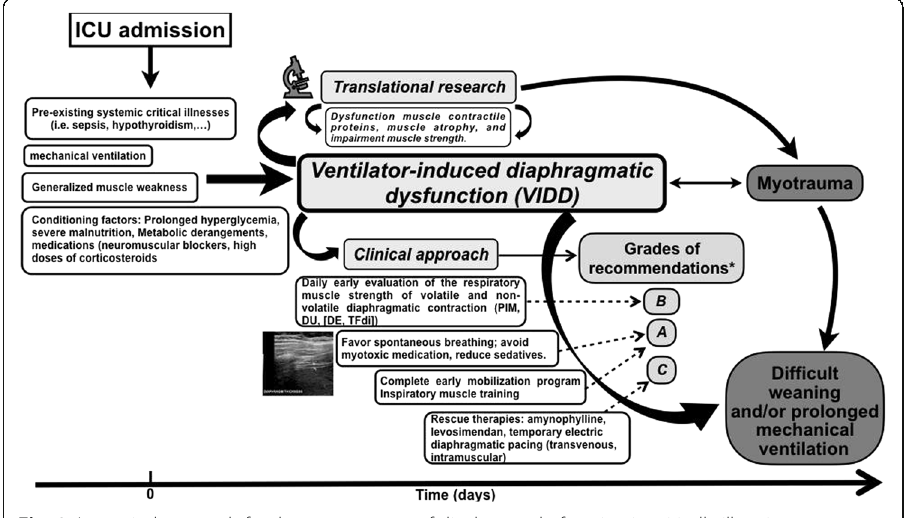
Fig. 3 A practical approach for the management of diaphragm dysfunction in critically ill patients. Abbreviations: DU, diaphragmatic ultrasound; DE, diaphragmatic excursion; PIM maximum inspiratory pressure; TFdi, thickening fraction. Asterisk refers to reference